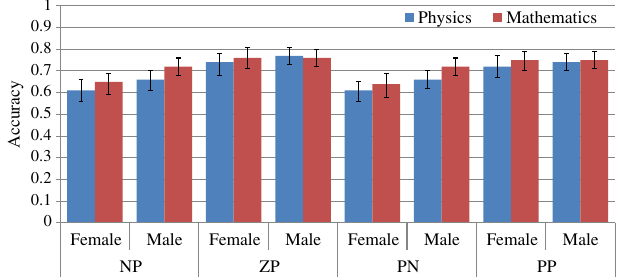
FIG. 7. Data from the 3-way interaction effect of function type, context, and gender. There are no significant differences between physics and mathematics for any gender and function type combination.